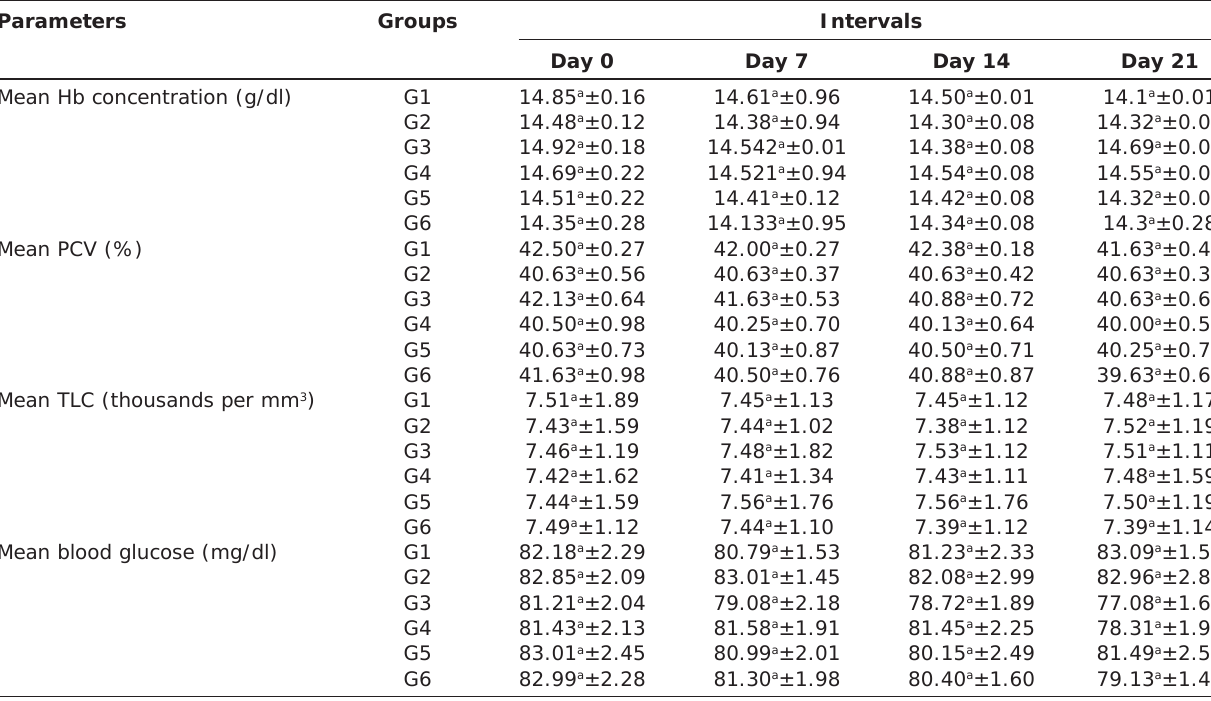
Table-1: Effect of F. tsiela Rox b extract and fresh juice on various haematological parameters in adult female Sprague Dawley rats. Parameters